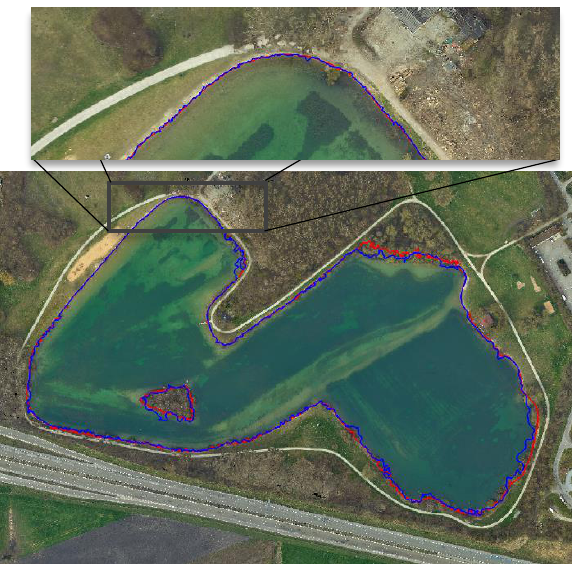
Figure 9. Shore lines calculated from intersection of water surface with image-DEM (blue) and laser-DEM